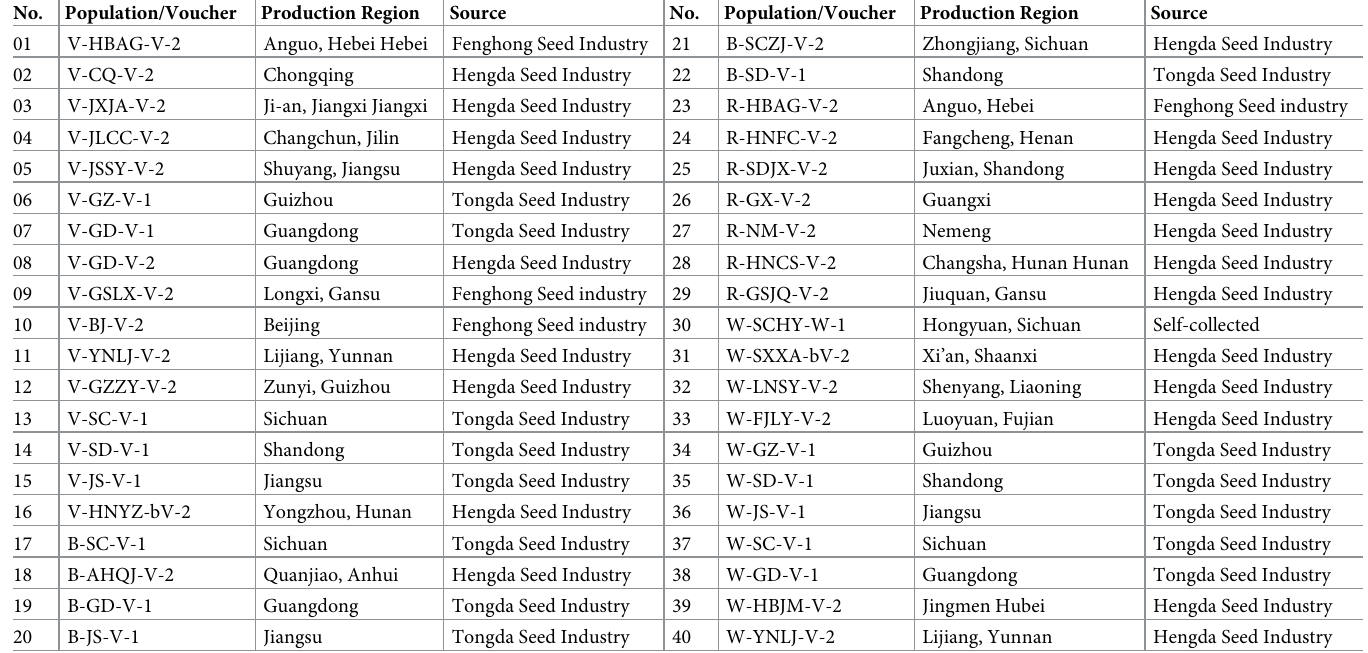
Table 1. Cultivated S . miltiorrhiza populations used in this